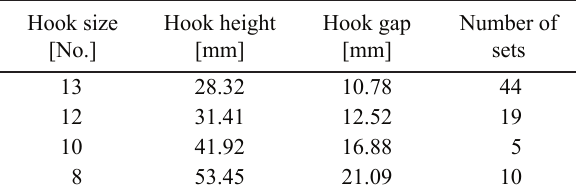
Information on the used hooks including hook size, hook height, and hook